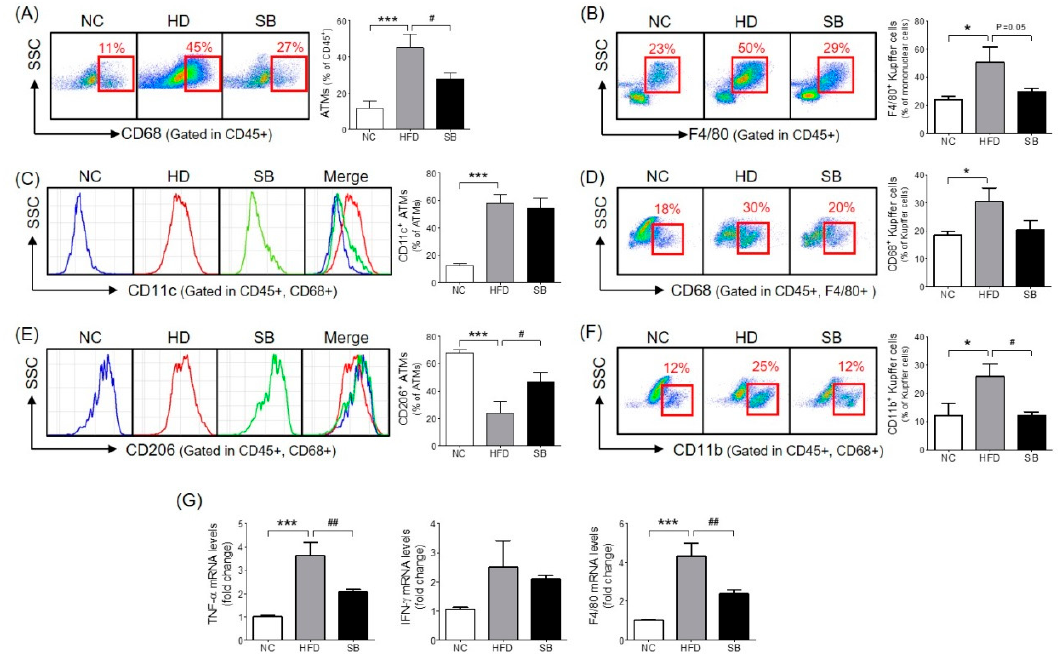
Figure 3. Effect of SB on ATM infiltration rate ( A ), CD206- and CD11c-positive ATMs ( C , E ), Kupffer cell infiltration rate ( B ), CD68- and CD11b-positive Kupffer cells ( D , F ) and inflammatory